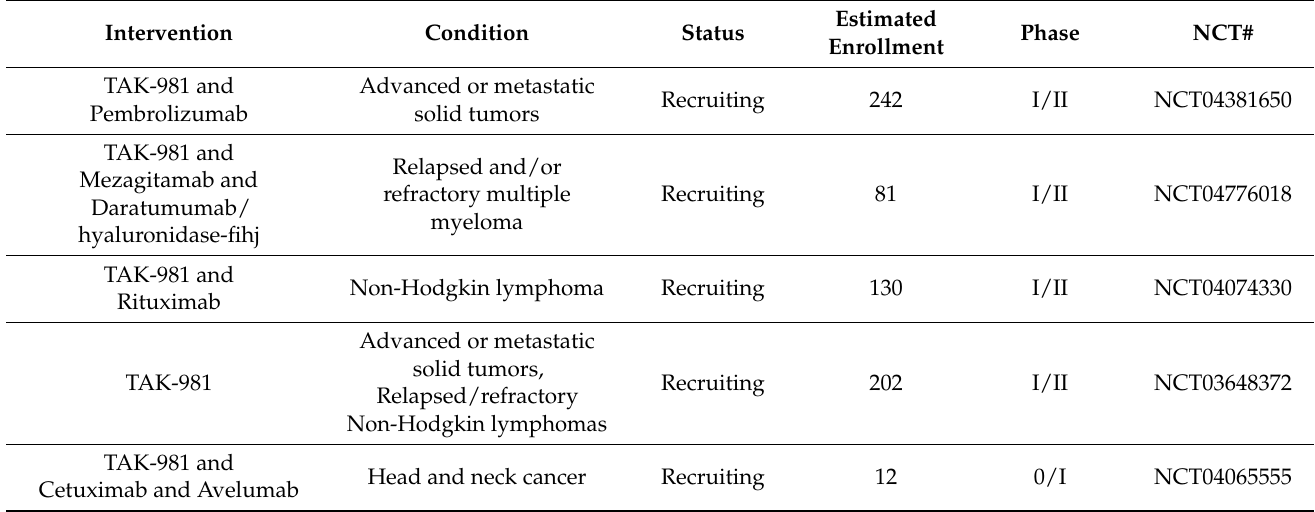
Table 3. Ongoing clinical trials of SUMO E1 inhibitor TAK-981. Data collected from clinicaltrials.gov (2.8.2021). Abbrevia- tions: NCT# national clinical trial identifier